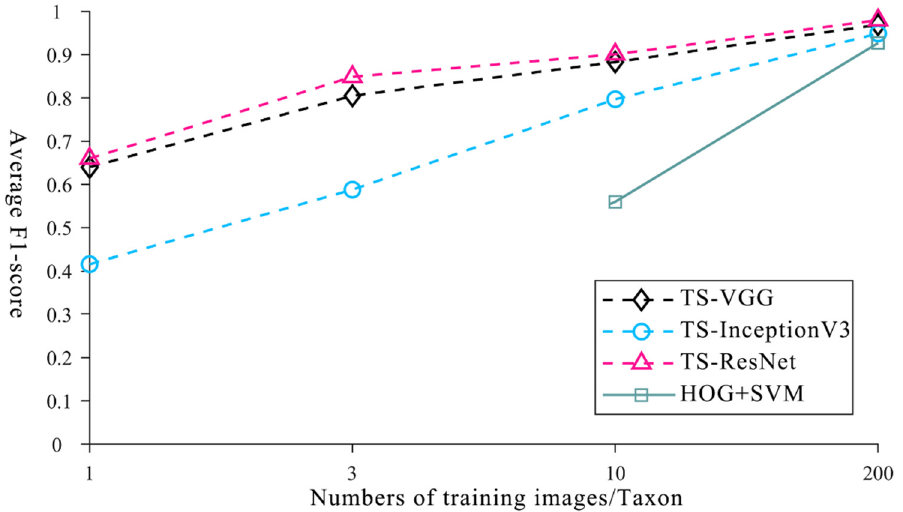
Figure 7. Average F1-score of machine learning, deep learning methods and TS-ResNet with different numbers of training images.